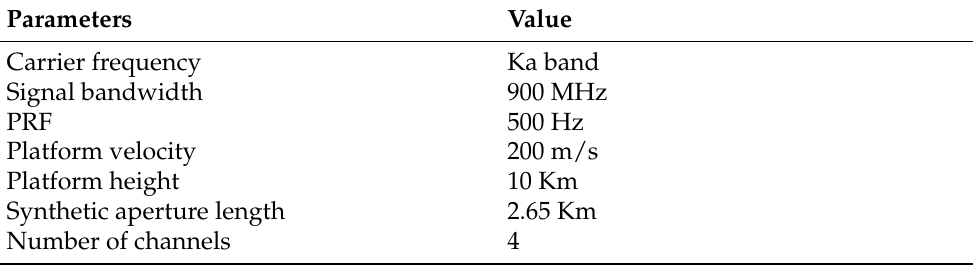
Table 4. Equivalent multichannel SAR experimental